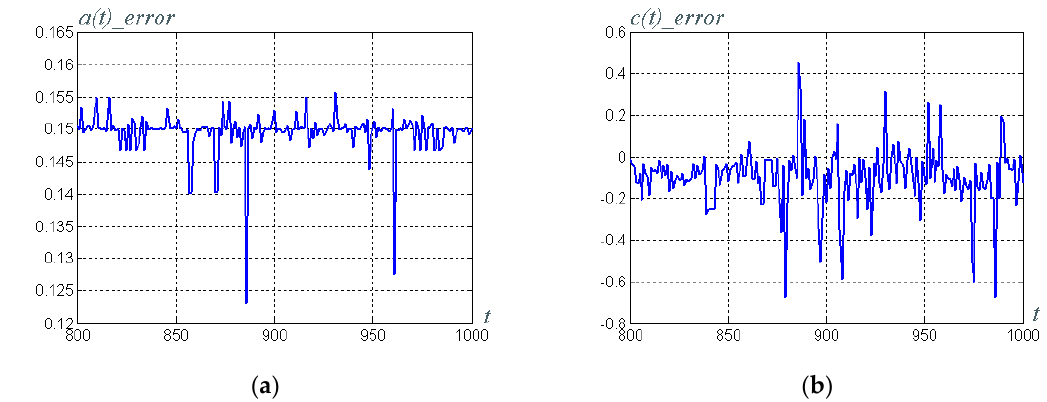
Figure 14. Transmitted signal reconstruction error: ( a ) Signal a reconstruction error; and ( b ) Signal c reconstruction error.